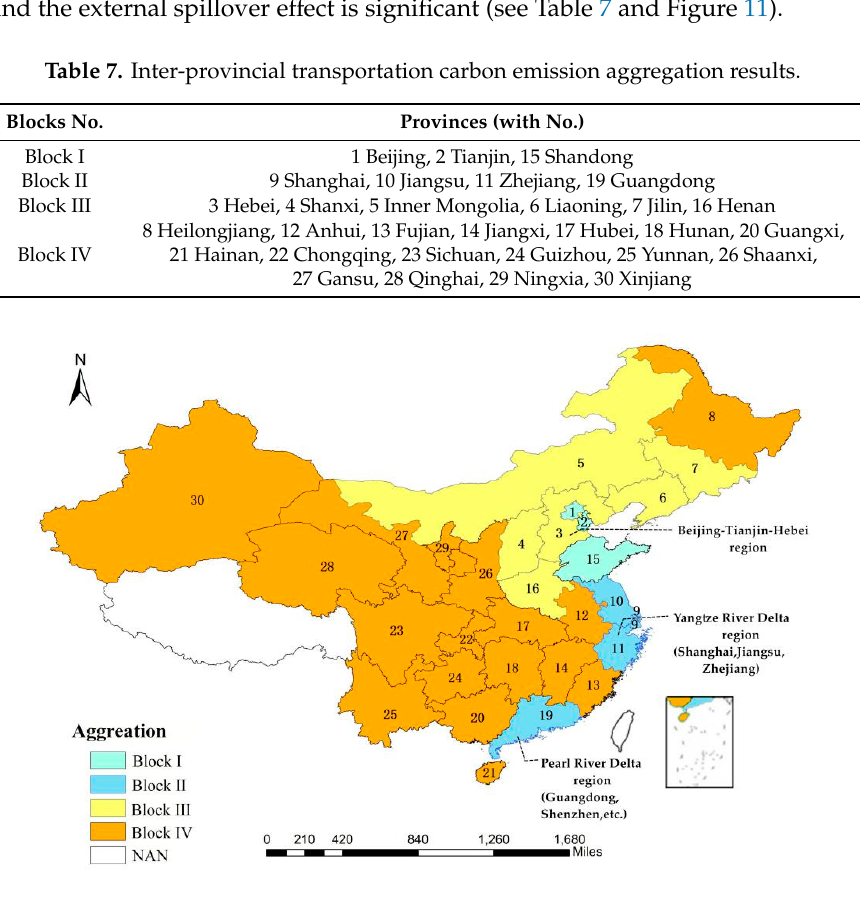
Figure 11. Block distribution of China's provincial transportation carbon emissions.